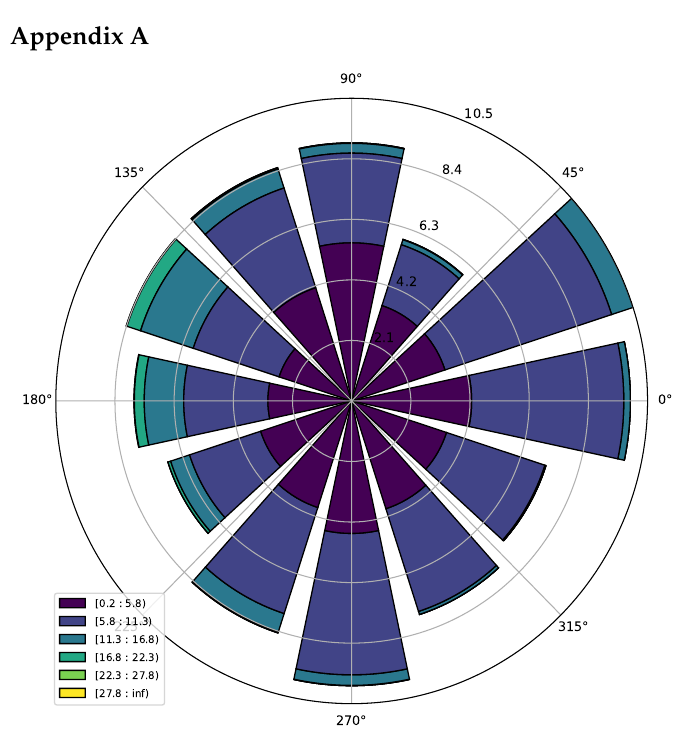
Figure A1. Twelve-bin wind rose for WM10 Butterworth at 60 m above ground level.